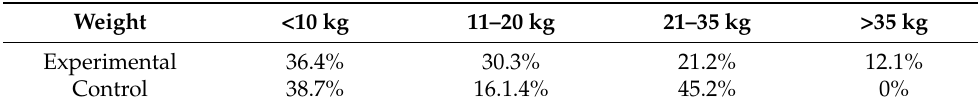
Table 6. Weight of female dogs (experimental and control) at